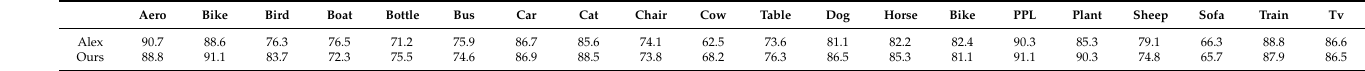
Table 6. Pascal VOC classification result breakdown.